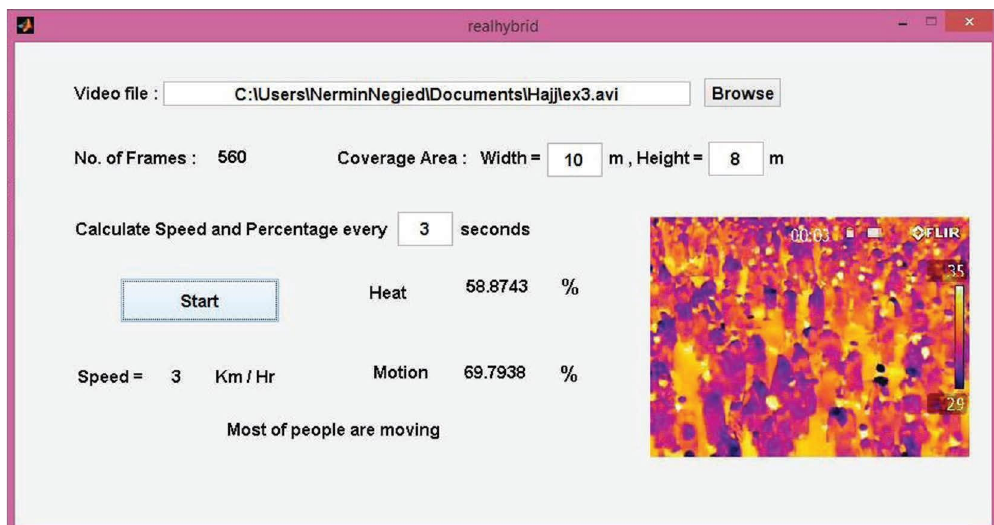
Figure 4: GUI representing the crowd density used in HSBS show classifcation from the people motion point of view [20].